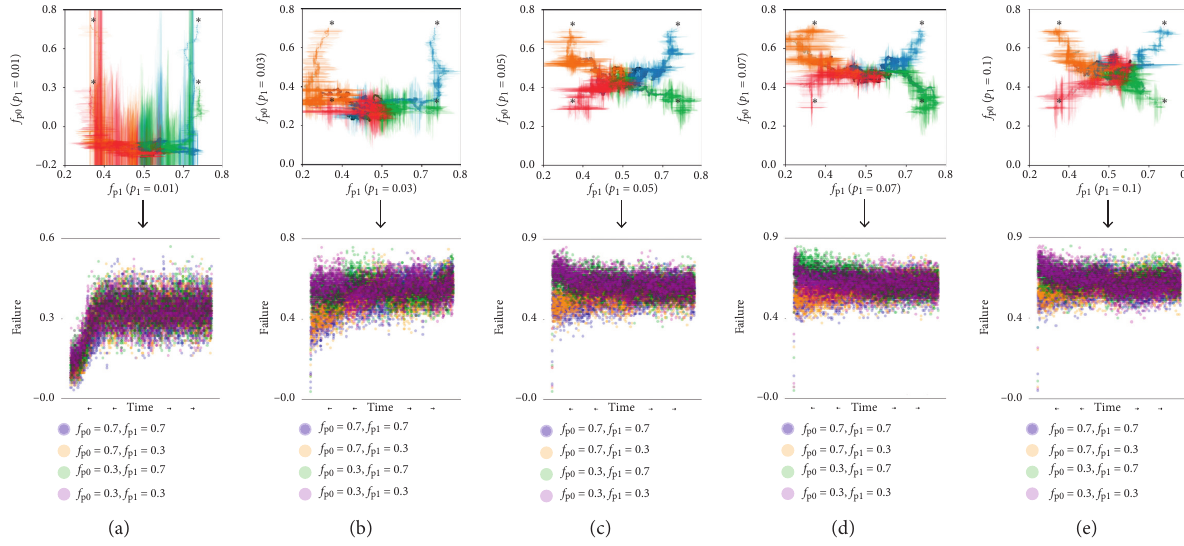
Figure 8: Patterns of evolution phenotypes obtained from the different starting point of the strategies with p (initialize parameters: nodes l � 0.1, s � 100, p � 1, c � 0.1, p � 0.9, p � 0.05, μ � 0.0, σ � 0.0125, p � 0.1, p � 0.01 ∼ 0.1, n � 100, connection p � 0.9, capital c � 1, f m p , max p , 1/2 r e n l � vertical axis, and t � 4000). The plots show their evolutionary trajectories with five observations including its variations ( f p0 � horizontal axis, dashed lines � coefficient of variation, dots � averaged value of the trait according to time step from the initial points; f p1 � 0.3, f � 0.7, blues: f � 0.7, f � 0.7, greens: f � 0.7, f � 0.3, and purples: f � 0.3, f � 0.3). The plots of the bottom oranges: f p0 p1 p0 p1 p0 p1 p0 p1 side represent the failure (vertical axis) according to the time step (horizontal axis) with the different initial points of the